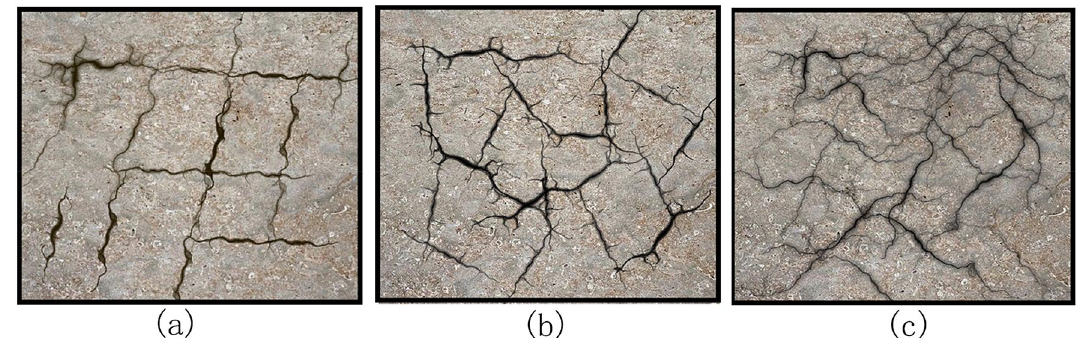
Figure 9. Schematic diagram of crack classification in three different states (( a ) networked cracks, ( b ) polygonal crack, and ( c ) random